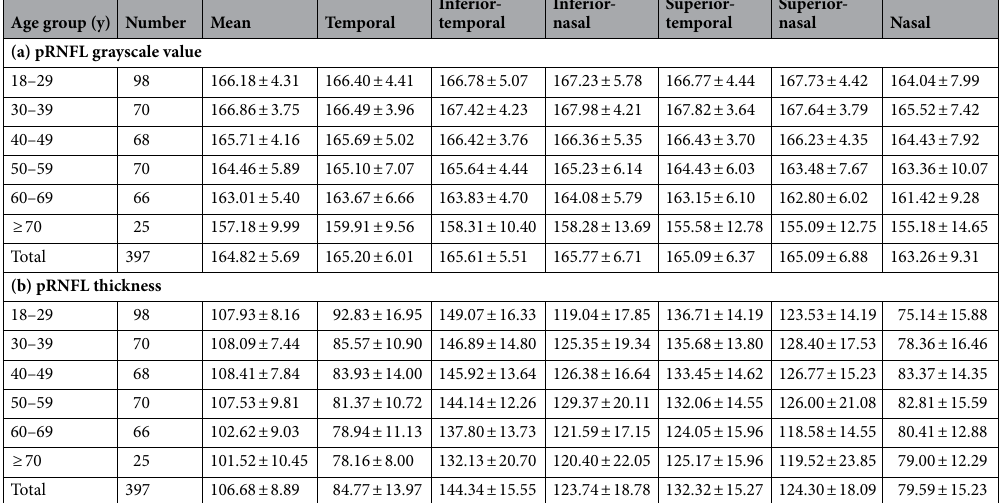
Table 2. Mean (± SD) of pRNFL parameters by age groups.